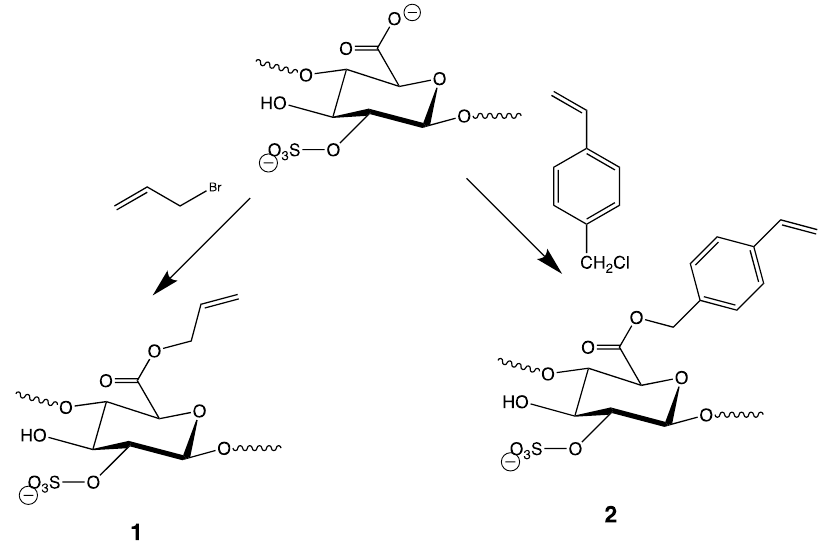
Figure 3. Preparation of heparin